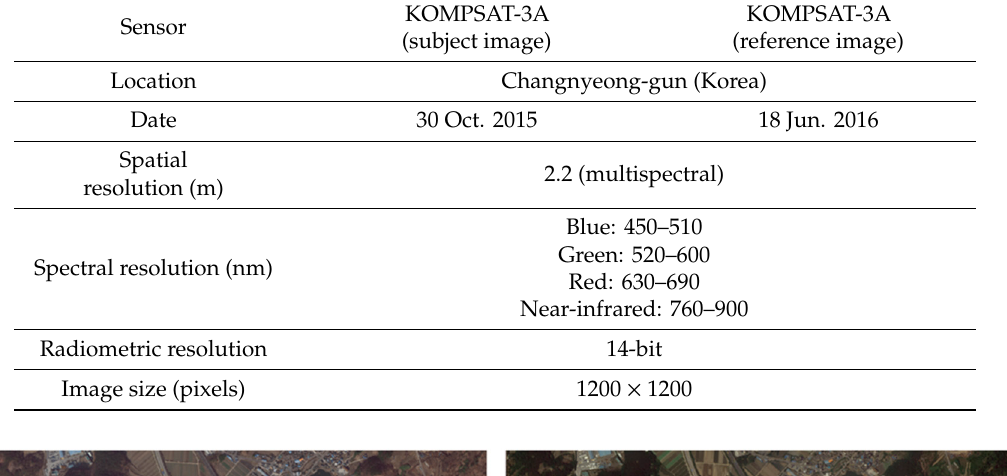
Table 1. Specifications of the satellite sensors.